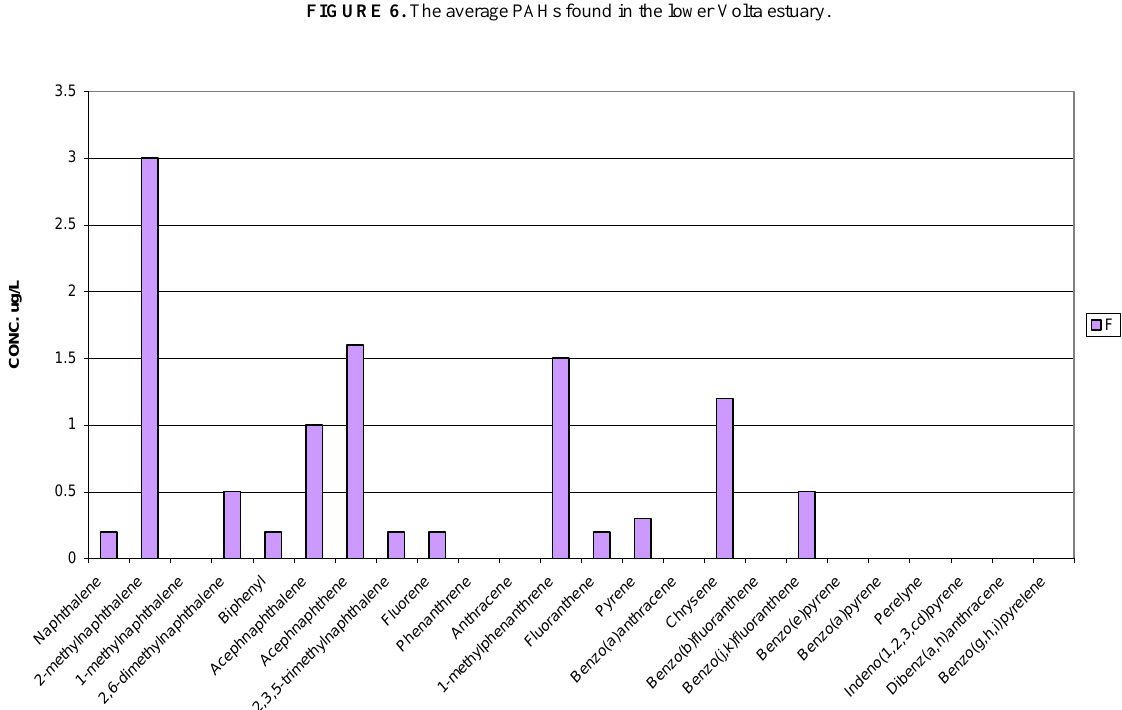
FIGURE 7. The average PAHs found in the Keta Lagoon